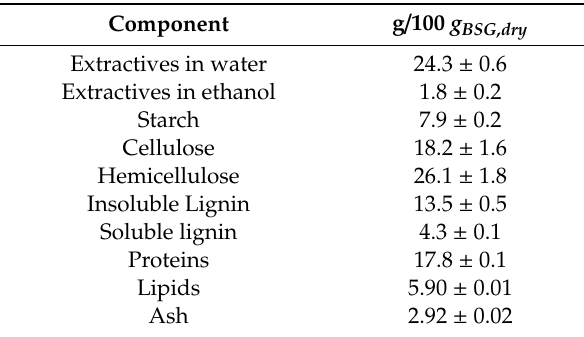
Table 2. Chemical composition of BSG from a local Spanish brewery.